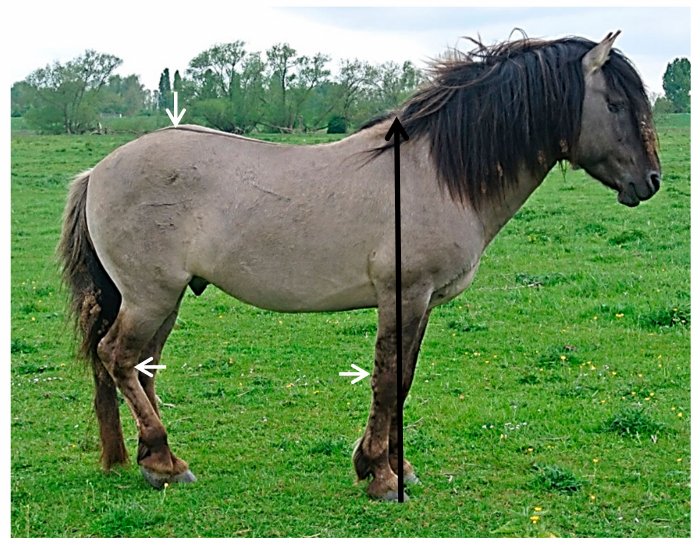
Figure 1. Wither height 130–140 cm (highest Thoracic dorsal spine) represented by the measurement from the ground to the black arrowhead in this Dutch Konik Stallion. Note: primitive stripes (white